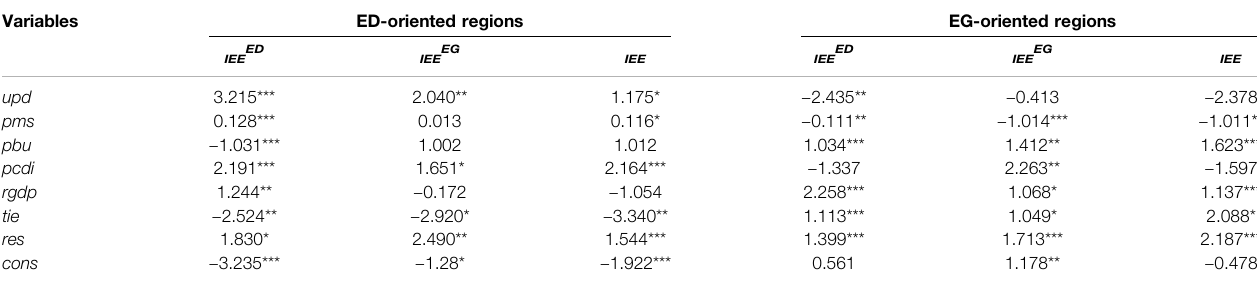
TABLE 6 | Regression results for factors impacting IEE.